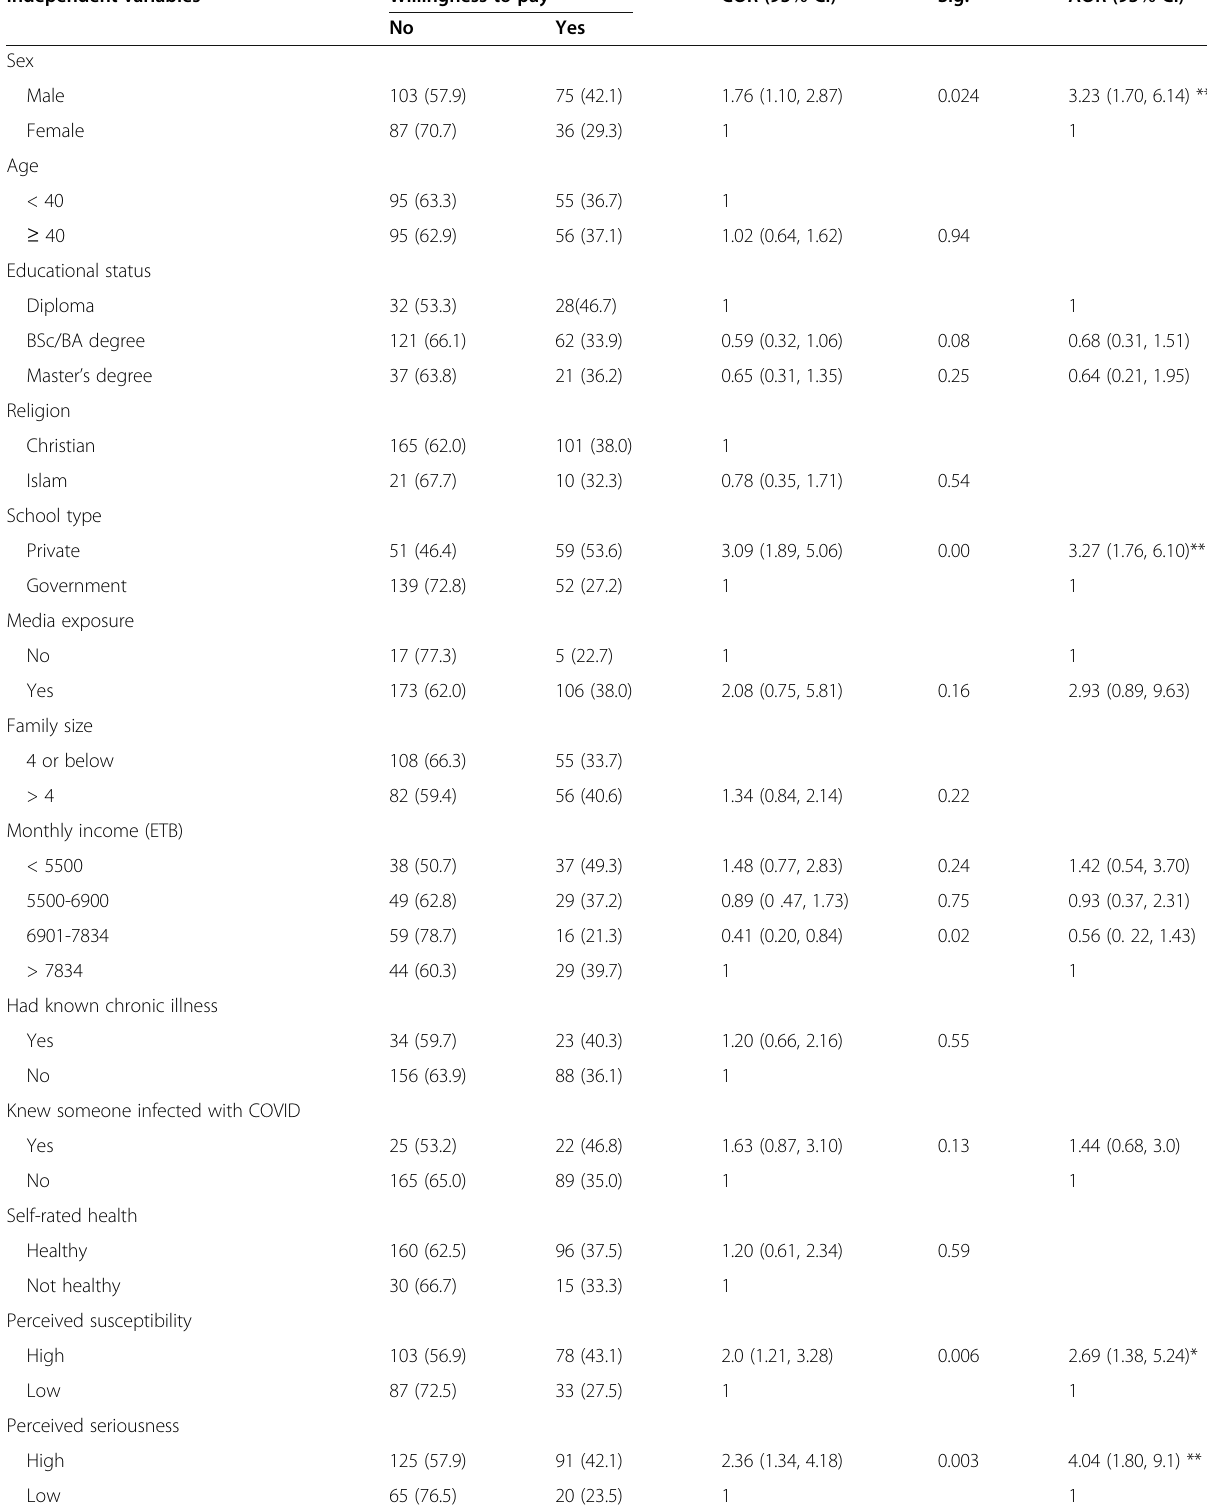
Table 3 Factors associated with willingness to pay for COVID-19 vaccine among school teachers in Gondar City, Northwest, Ethiopia (n =